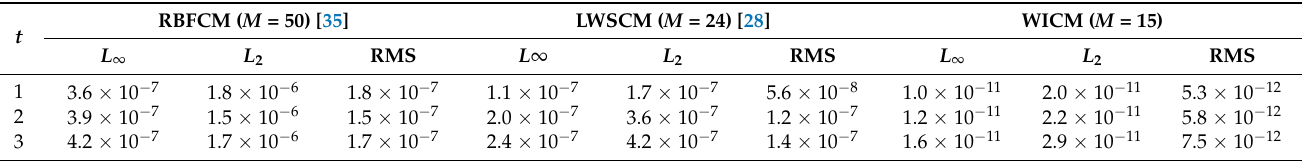
Table 3. Error norms of numerical solutions at different times t for Example 1 with c = 0.05.